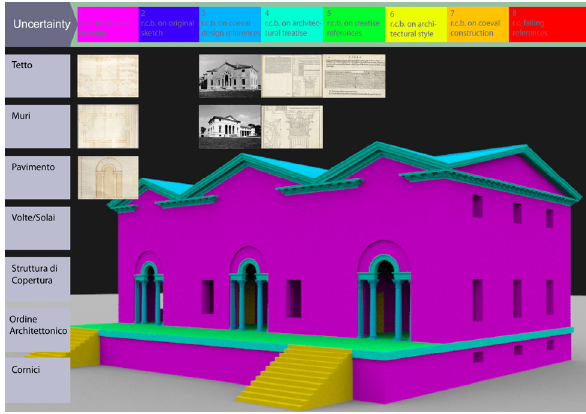
Figure 7. A. Palladio, Villa for a twins. 3D modeling reconstructive conjecture uncertainty map 4. BEYOND THE SEMANTIC STRUCTURE OF